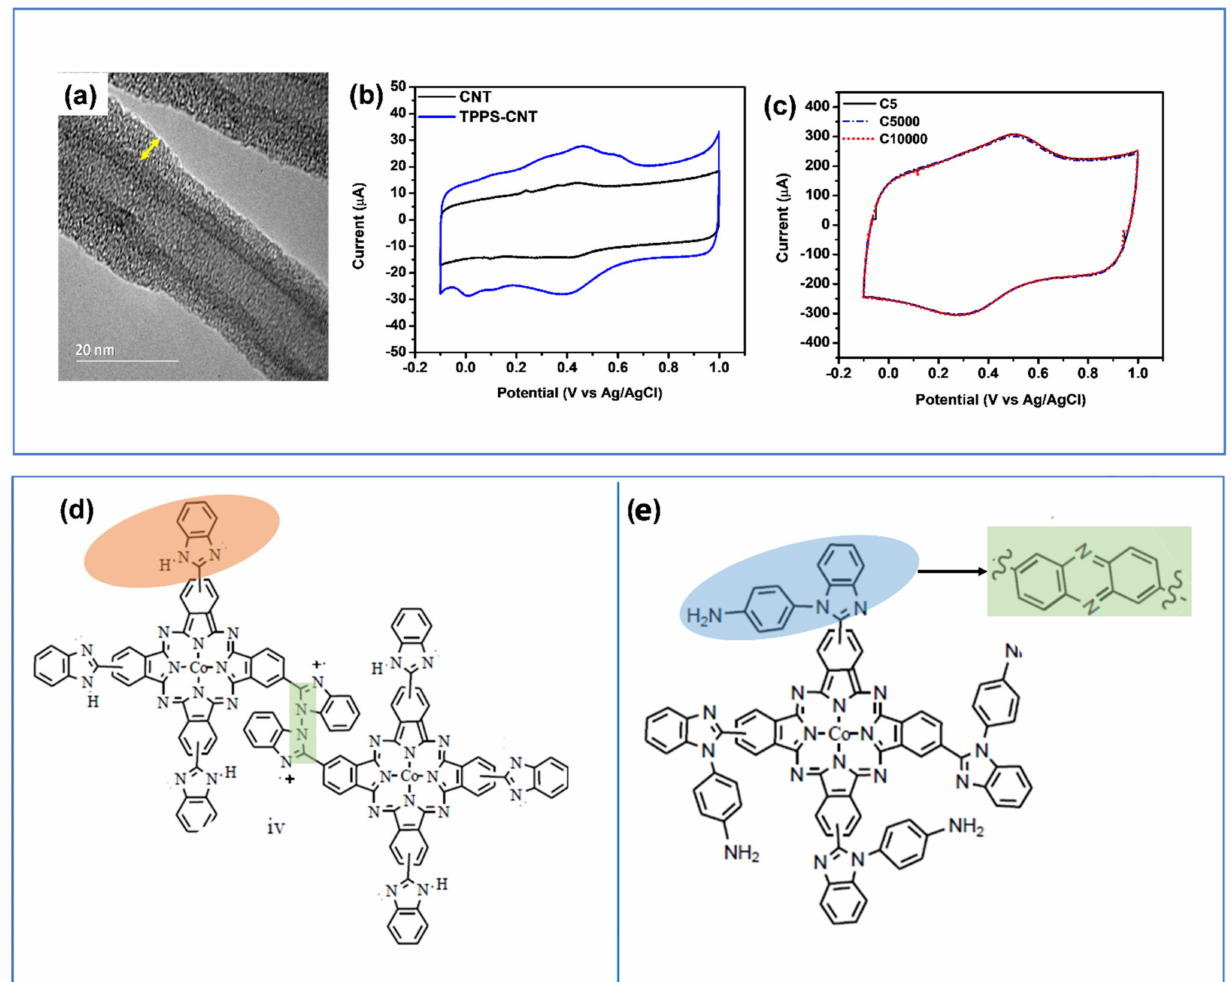
Figure 11. ( a – c ) TEM image of TPPS-CNT composite electrode with thickness highlighted with yellow arrow, CV profiles comparison of CNT and TPPS-CNT and CV profile of the composite after 5, 5000, and 10,000 cycles, ( d , e ) Chemical structure of ( a ) cobalt-poly-tetraaminophenylbenzimidazole phthalocyanine (Co-p-TABim-Pc-rGO) and Co-poly-tetrabenzimidale (Co-p-TBIm-Pc-rGO. Reproduced with permission from Refs.